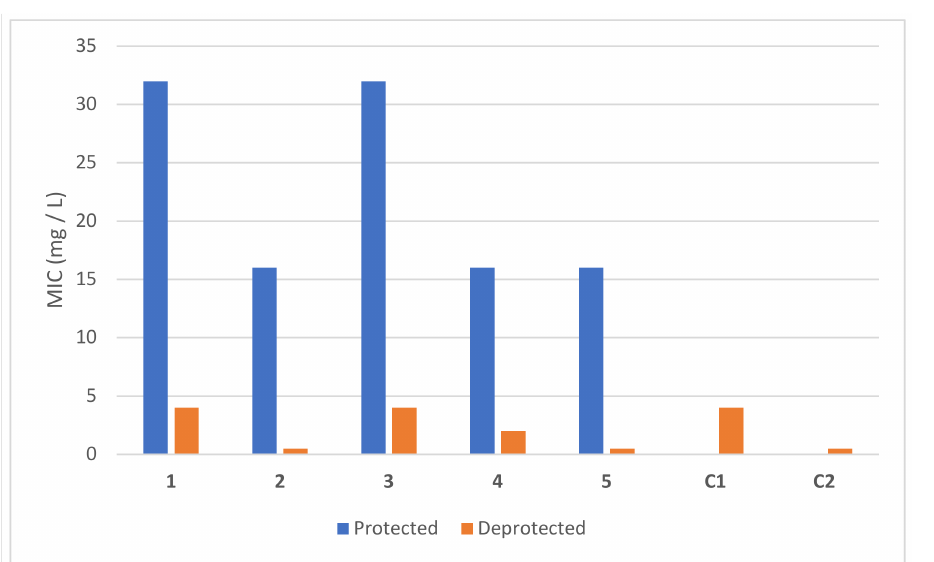
Figure 6. Graphic comparison of MIC values on E. coli ATCC 25922 strain of the protected and deprotected forms of the photoreleasable quinolones 1 – 5 . In blue it is represented the protected form (BODIPY linked to the antibiotic). In orange it is shown the activated form (after irradiation of the sample, which induces the release of the antibiotic). C1 and C2 refer to the quinolones’ control experiments (C1 = nalidixic acid, C2 = BOC-ciprofloxacin) in 60:40 DMSO:H 2 O. Note that in the case where MIC value is >32 mg/L, a value of 32 has been represented, and for the compound with MIC 8–16 mg/L, the higher value has been depicted. These experiments were performed in triplicate and the same result was obtained in all experiments.